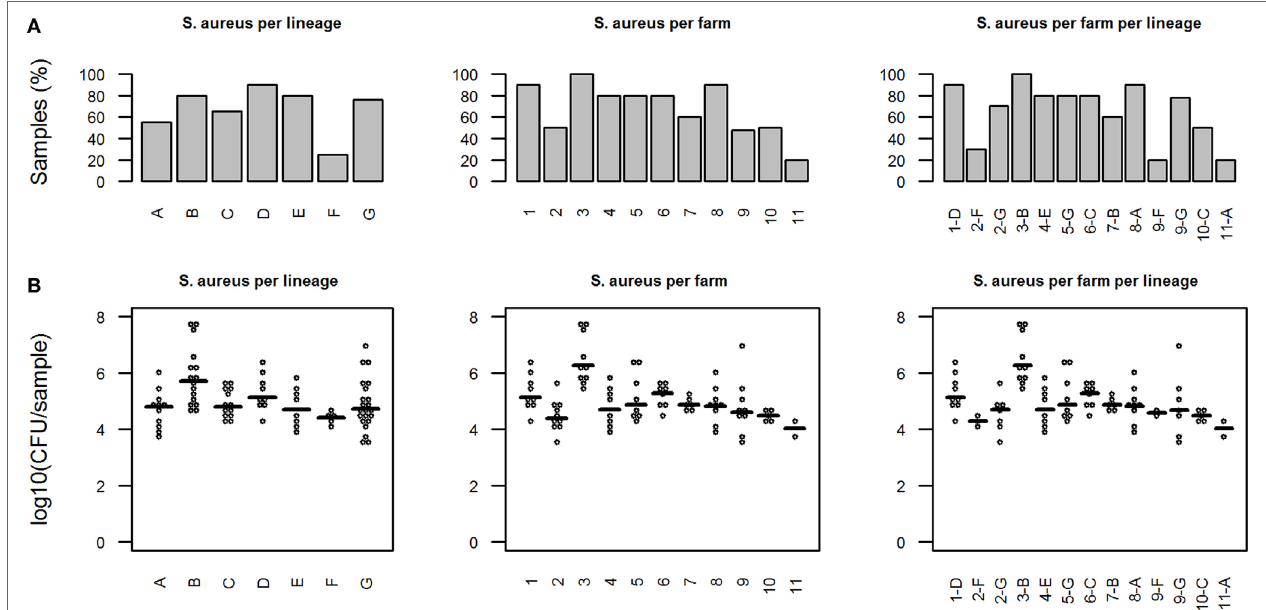
FigUre 1 | Presence of Staphylococcus aureus in different pig lineages. (a) Percentage of S. aureus -positive samples. (b) Quantitative results from S. aureus - specific real-time-PCR (only S. aureus -positive samples). Horizontal bars indicate median of the amount of S. aureus in positive samples. In graphs, “ S. aureus per farm per lineage” the x -axis indicates the combination of farm number and lineage